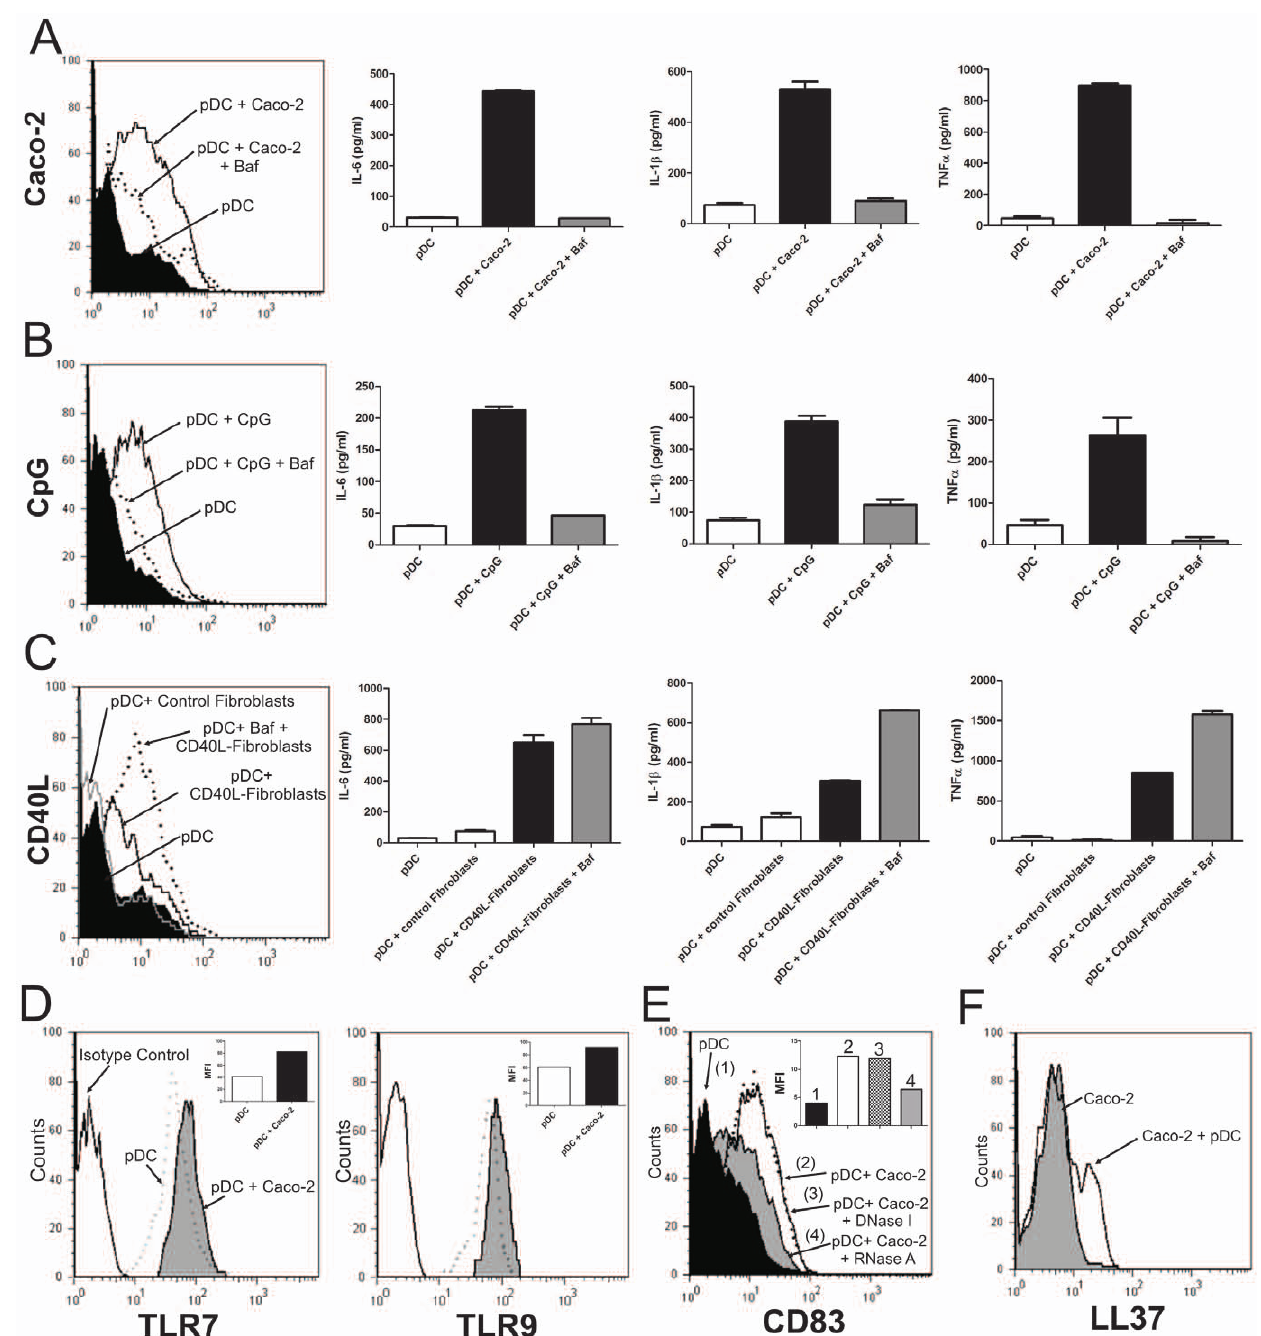
Figure 7. Analysis of the mechanisms through which epithelial cells induce the activation of pDCs. ( A–C ) pDCs (1 6 10 5 /200 m l) were pre- incubated or not with Bafilomycin A1 (50 ng/ml) for 30 min. Then, they were cultured for 12 h at 37 u C alone or in the presence of confluent Caco-2 cells ( A ), the CpG-containing oliguncleotide 2006 (2.5 m g/ml) ( B ), confluent control fibroblasts or confluent CD40L-expressing fibroblasts ( C ). Then, the expression of CD83 and the production of the cytokines IL-6, IL-1 b and TNF- a was evaluated by flow cytometry and ELISA, respectively. Representative histograms (n=3–4) are shown. Graph bars show a representative experiment made by duplicate ( D ) pDCs (1 6 10 5 /200 m l) were cultured alone or in presence of confluent Caco-2 cells for 12 h. Then, the expression of TLR7 and TLR9 was evaluated by intracellular staining and flow cytometry. A representative experiment (n=3) is shown. ( E ) Caco-2 were grown to confluence in 96 well flat bottom plates. pDCs (1 6 10 5 /200 m l) were cultured alone (controls) or with Caco-2 cells for 12 h, in the absence or presence of DNase I (15 m g/ml) or RNase A (10 m g/ml). Then, pDCs were harvested and the expression of CD83 was analyzed by flow cytometry in the gate of CD123-positive cells. Dot-plots from a representative experiment (n=4) are shown. ( F ) Caco-2 cells were grown to confluence in 96 well flat bottom plates. They were cultured for 12 h with or without pDCs (1 6 10 5 /200 m l). Then, the expression of LL37 by Caco-2 cells was analyzed by intracellular staining and flow cytometry, in the gate of CD123- negative cells. A representative experiment (n=4) is shown.